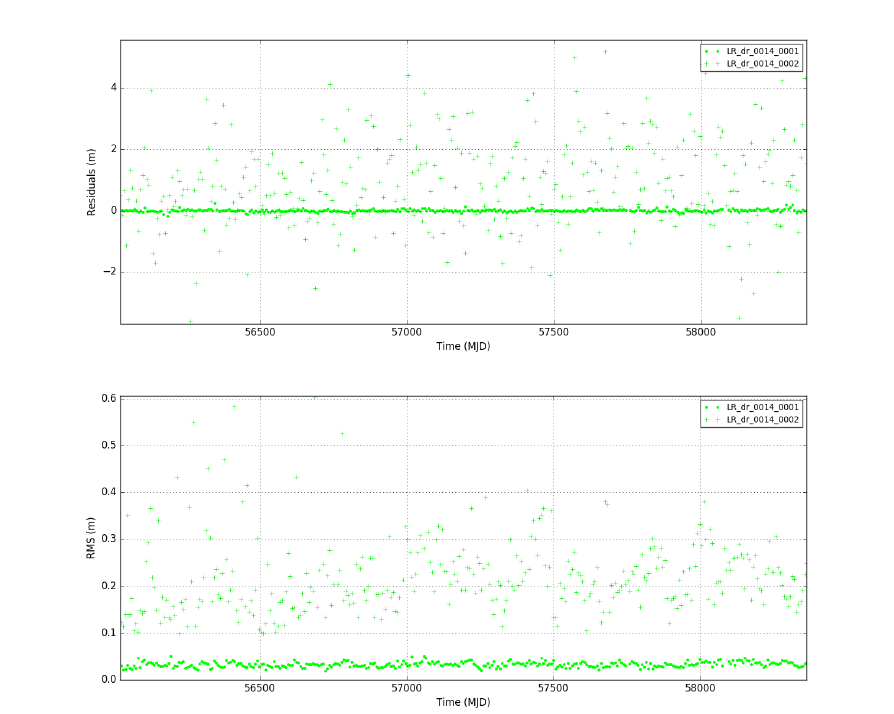
Figure 13. LARES POD results. Top: Range residuals. Bottom: RMS of the range residuals.